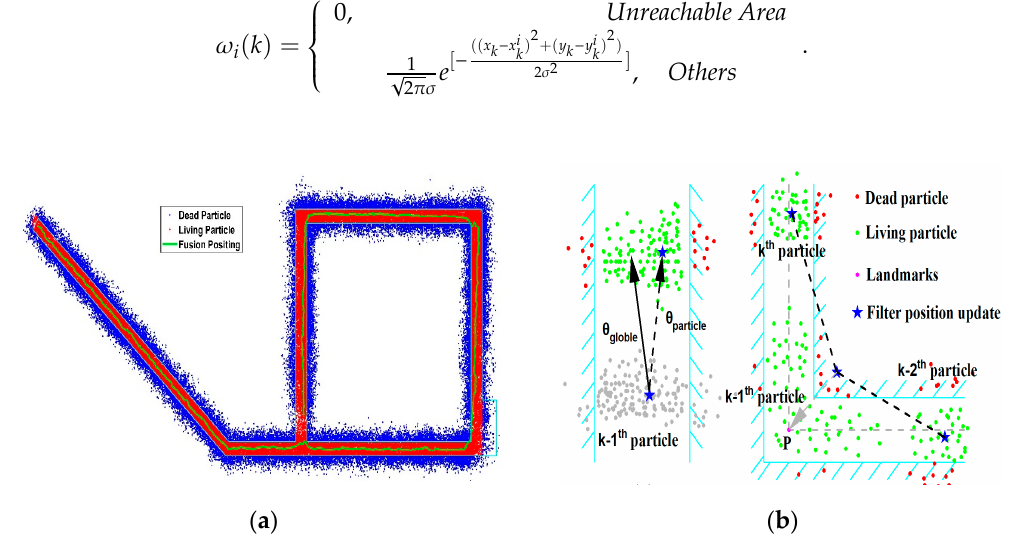
Figure 9. Particle filtering algorithm assisted by map matching; ( a ) the distribution of particle (the blue dot represents a dead particle, and the red dot represents a living particle); ( b ) the diagram of trajectory correction.